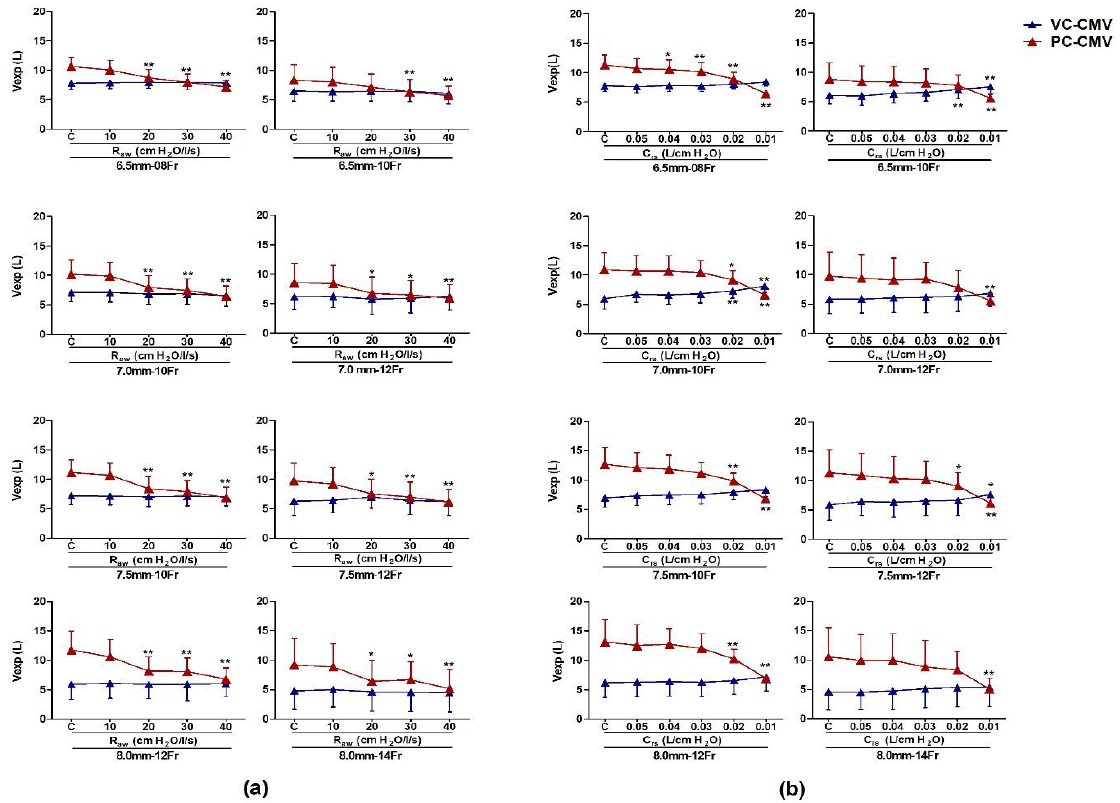
Figure 5. Comparison of the changes in Vexp effects in different respiratory systems and ventilation modes. Various ETTs paired with SCs for CSS conducted endotracheal suctioning in airway resistance of pulmonary mechanics for the obstructive system ( a ) and lung compliance of pulmonary mechanics for the restrictive system ( b ) with VC-CMV or PC-CMV. PC-CMV: pressure control continuous mandatory ventilation, this mode set inspiratory pressure at 20 cm H 2 O with inspiratory time at 1 sec; VC-CMV: volume control continuous mandatory ventilation, this mode is set to VT 0.6 L with peak flow 60 Lpm; C: control group (0.08 L · cm H 2 O − 1 of C rs and 5 cm H 2 O · L − 1 · s of R aw ); Vexp: expiratory minute volume; R aw : airway resistance; C rs : lung compliance; ETT: endotracheal tube; SC: suction catheter; 6.5 mm − 08 Fr: 6.5 mm ETT paired with 08 Fr SC, and so on. The closed suctioning procedure was repeated three times. The error bars represent the standard deviation of 30 breaths in each of the pulmonary mechanic scenarios (five airway resistance levels and six lung compliance levels). The independent samples t -test was used to compare with the control group. * p < 0.05, ** p < 0.01.